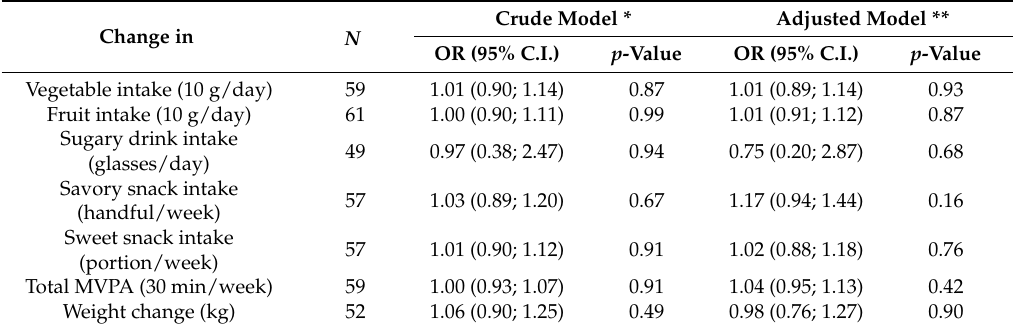
Association between the change in dietary intake and physical activity during the preconception lifestyle intervention and metabolic syndrome 3–8 years after randomization †. Change in